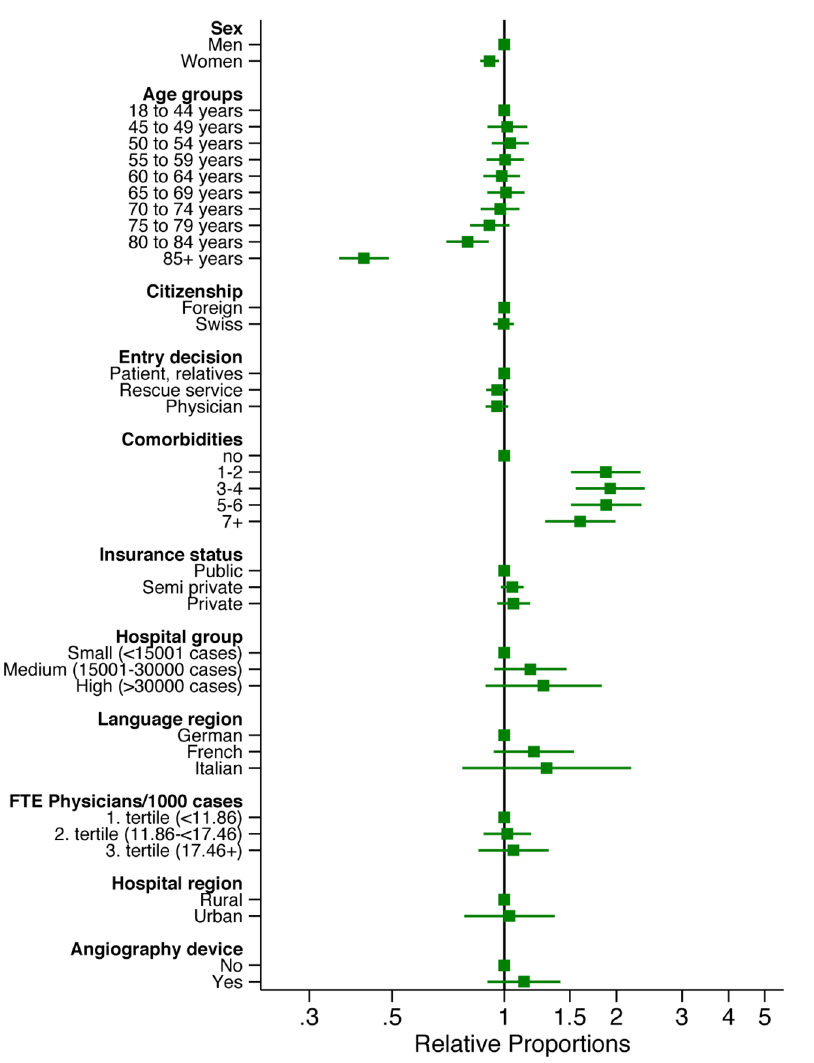
Fig 2. Results of multilevel Poisson regression for